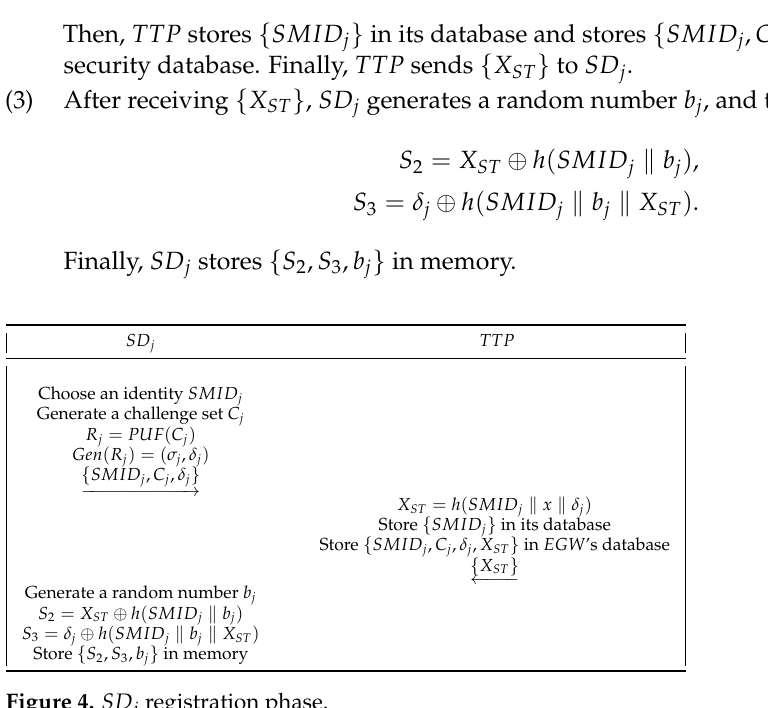
Figure 4. SD j registration